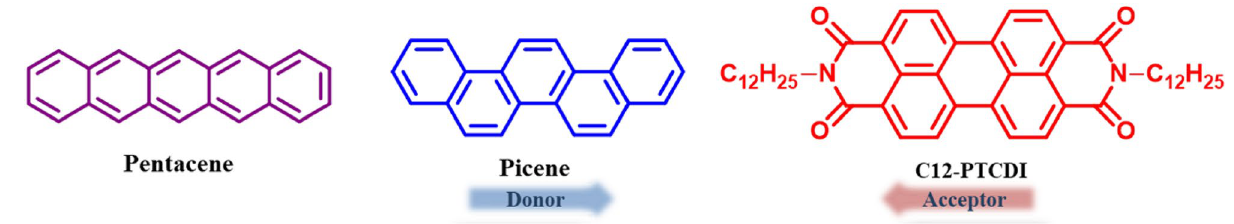
Figure 1. Molecular structures of pentacene, picene ( D ) and C12-PTCDI ( A